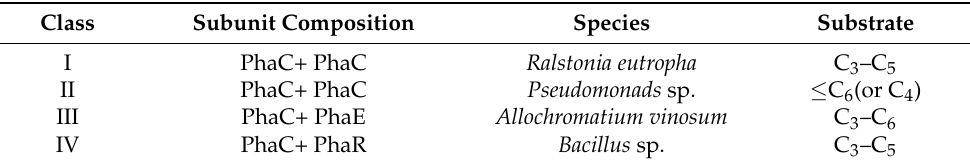
Table 3. The classification of PHA